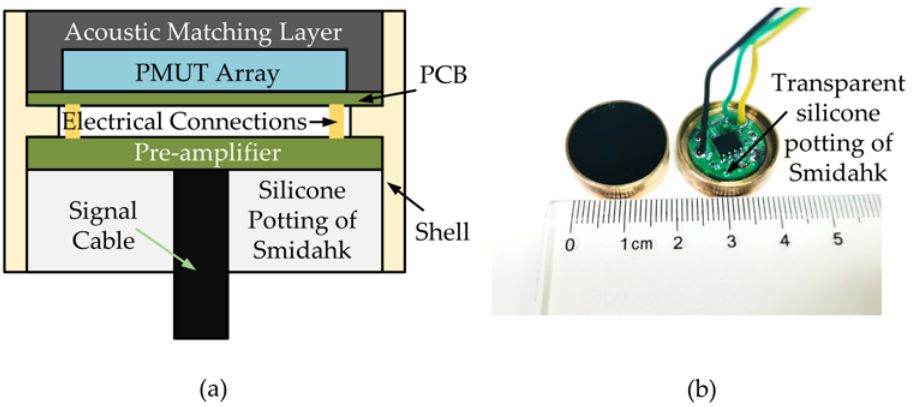
Figure 4. MEMS hydrophone assembling and packaging: ( a ) the structure of the hydrophone, ( b ) photograph of the packaged hydrophone.